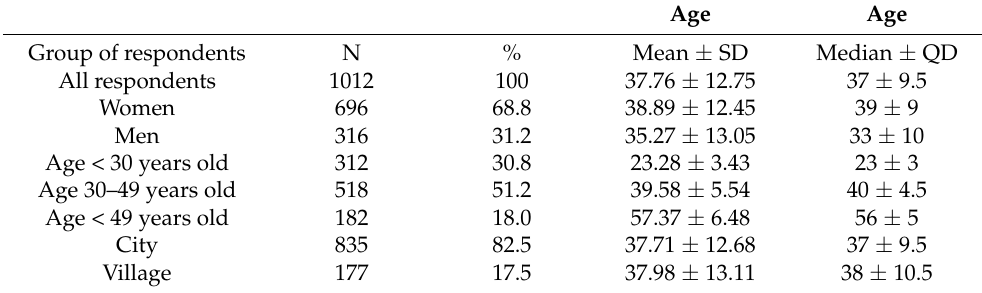
Table 1. The number of respondents and the average age according to the division into